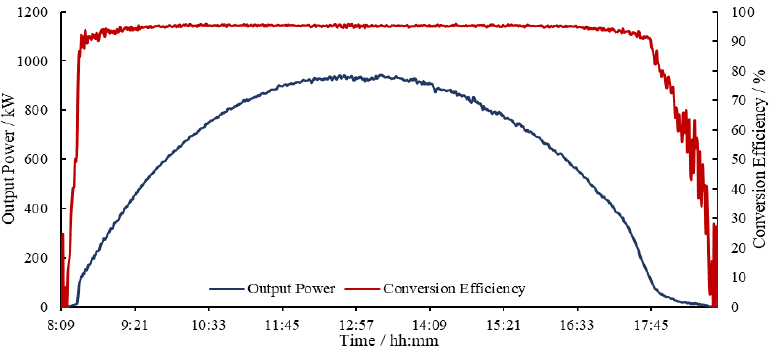
Figure 34. Output power and conversion efficiency of the DC/DC converter on a sunny day. Figures 35 and 36 are operation curves of DC/DC converter on a typical cloudy day.